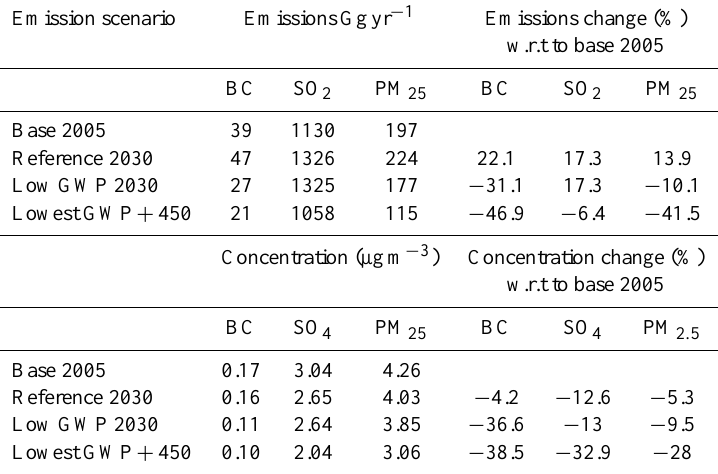
Table 1. Summary of changes in Central Asia (CA) region (see Fig. 1 for CA region definition) emissions and concentration under the future emission scenarios (see Sect. 3.9 for more